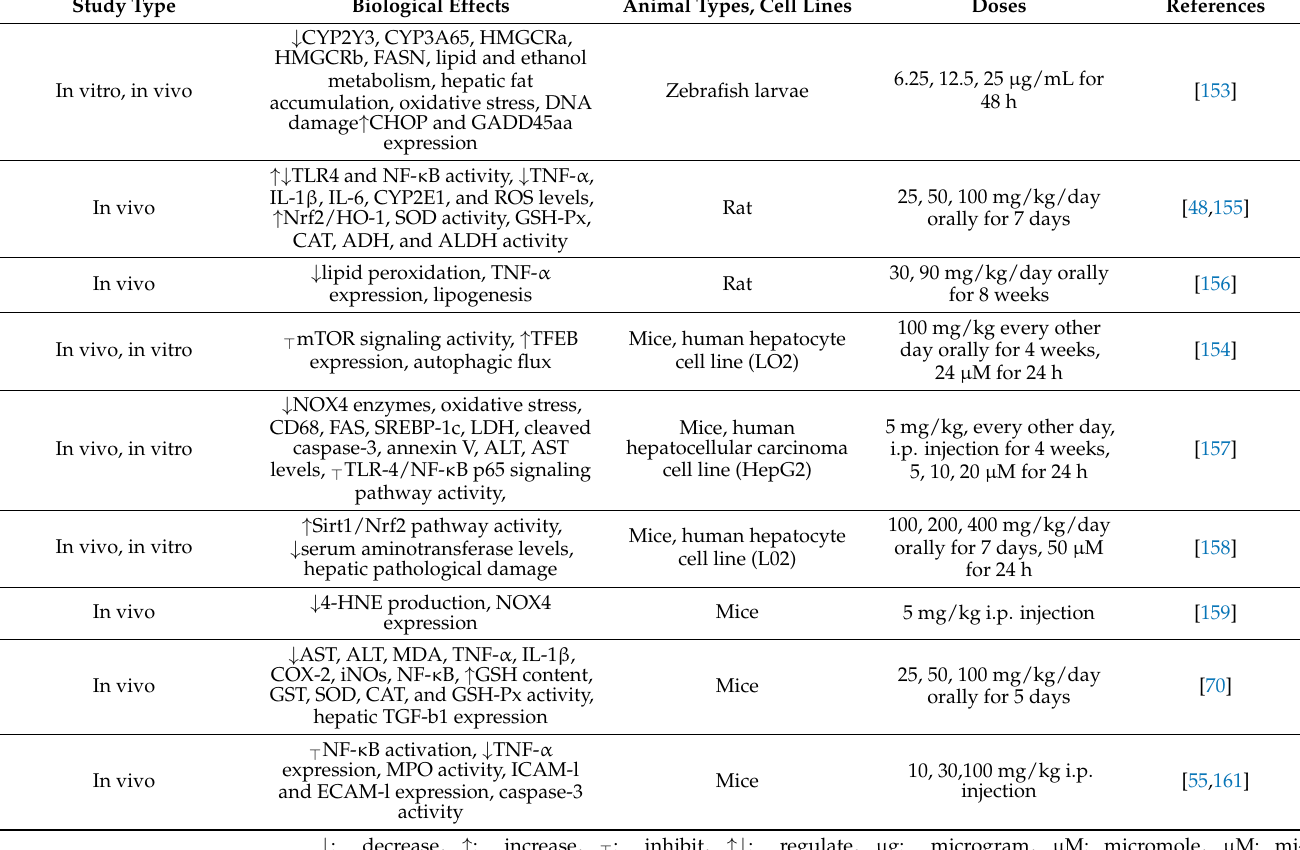
Table 3. Hepatoprotective effects of